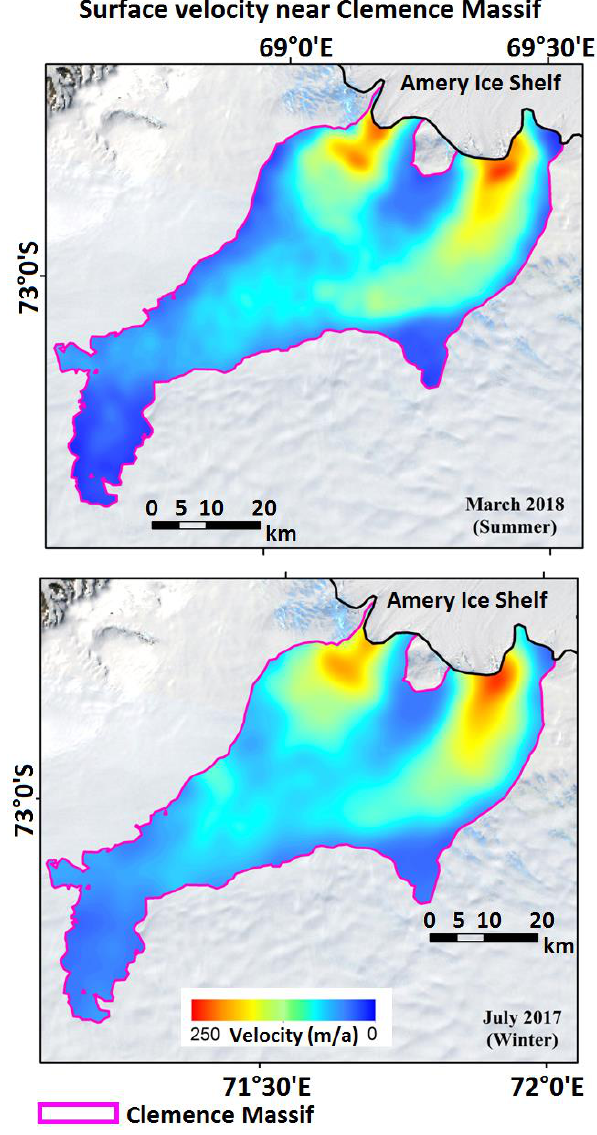
Figure 5. Summer and winter velocity near the Clemence Massif, East